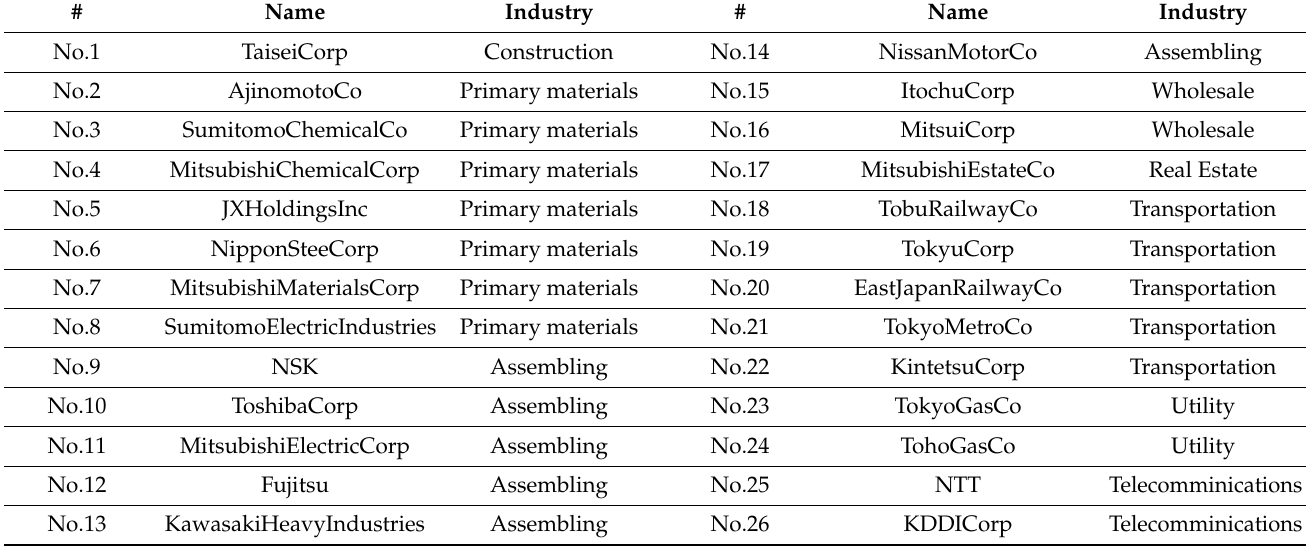
Table A1. Breakdown of selected